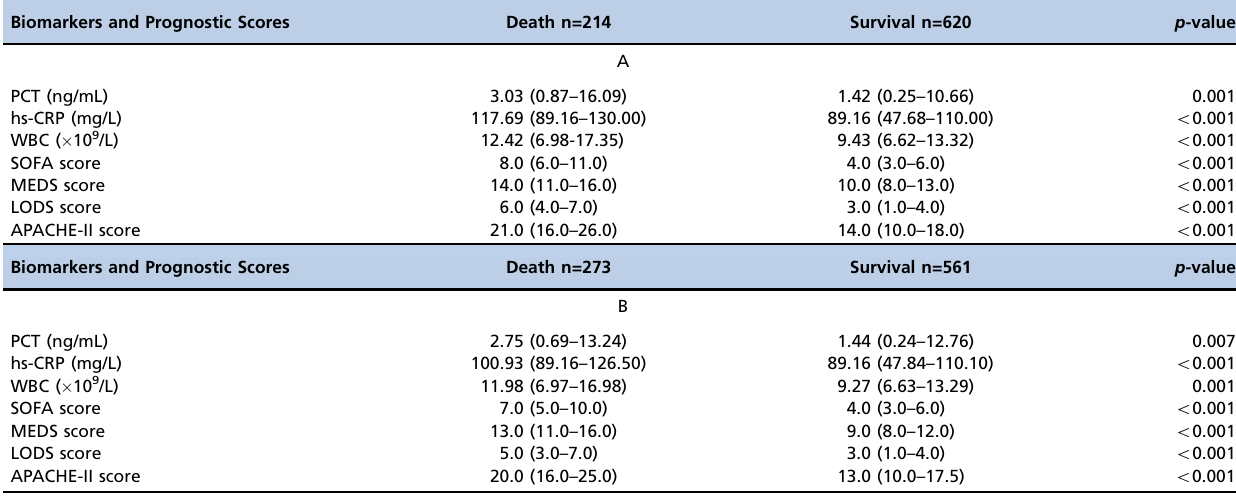
Table 2 - Prognostic scores and laboratory findings for sepsis and septic shock predicting early (A) and late (B) mortality. Biomarkers and Prognostic